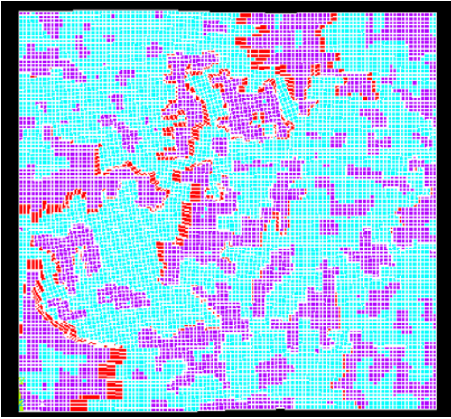
Fig. 6. Displacement pattern within a randomly structured composite showing interfacial displacement jumps.